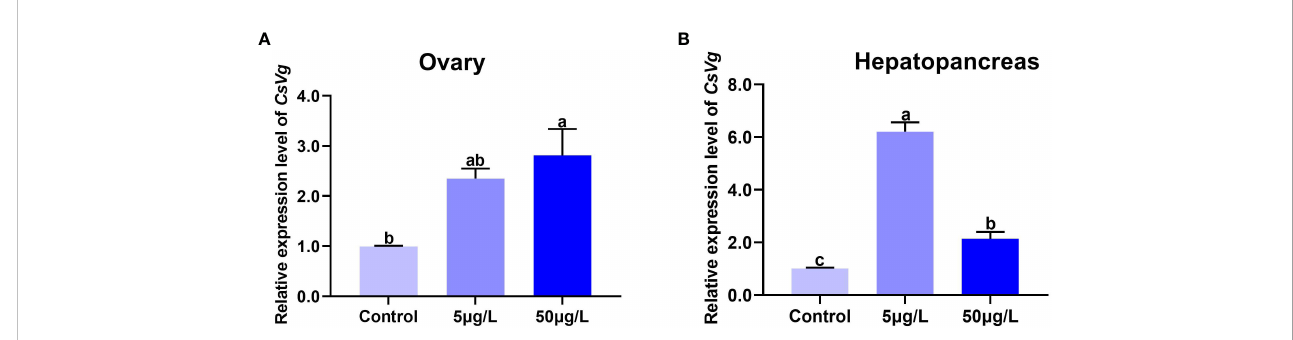
FIGURE 8 The expression level of CsVg in the ovary (A) and hepatopancreas (B) of C sinensis by different concentrations of estradiol. The columns with different letter indicate signi fi cant difference ( P <